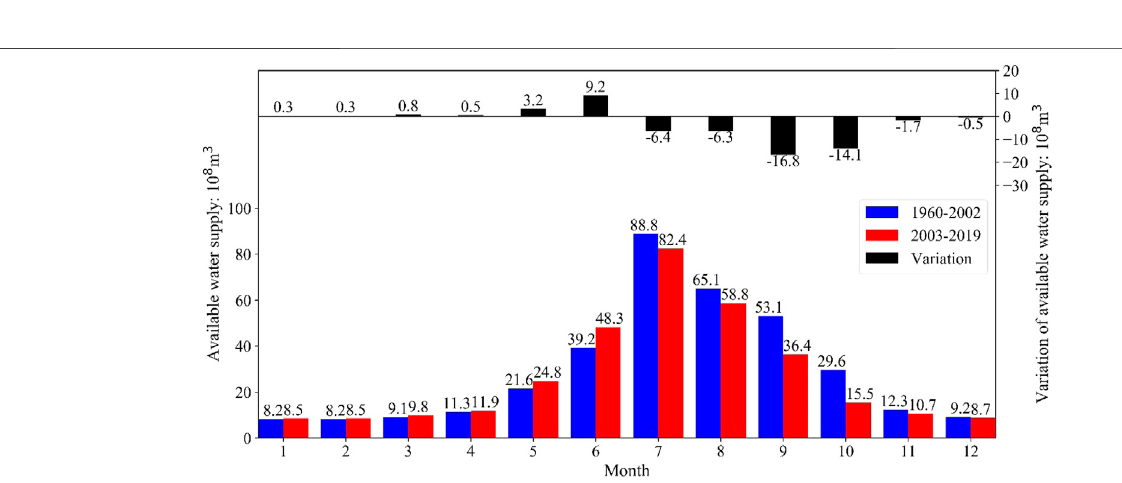
Frontiers in Earth Science |